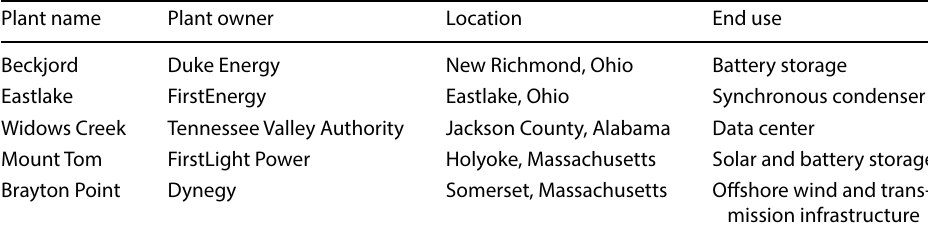
Table 3 Repurposed coal power plant